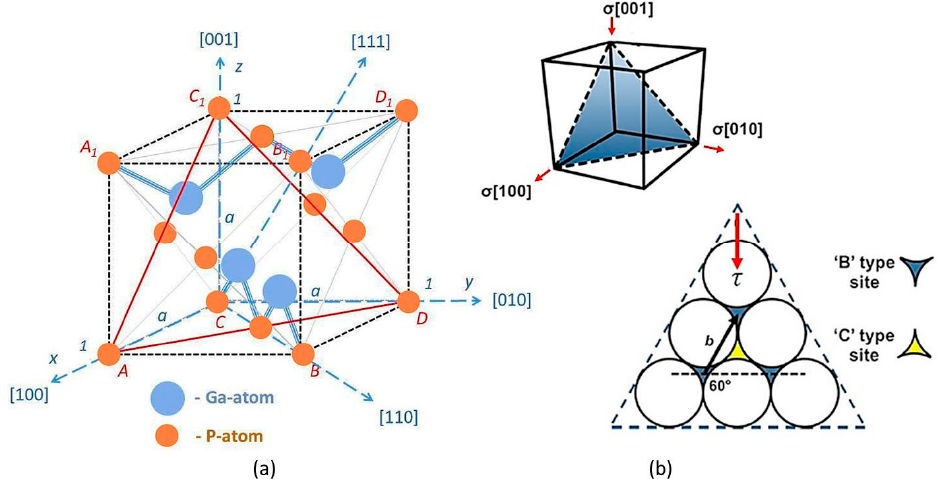
Figure 35. ( a ) The zinc-blended GaP structure. The crystallographic plane of interest ADC 1 is outlined; ( b ) conducting the tensile biaxial strain σ during GaP/GaAs heteroepitaxy [85]. (Reproduced from [85] with the permission of AIP Publishing).